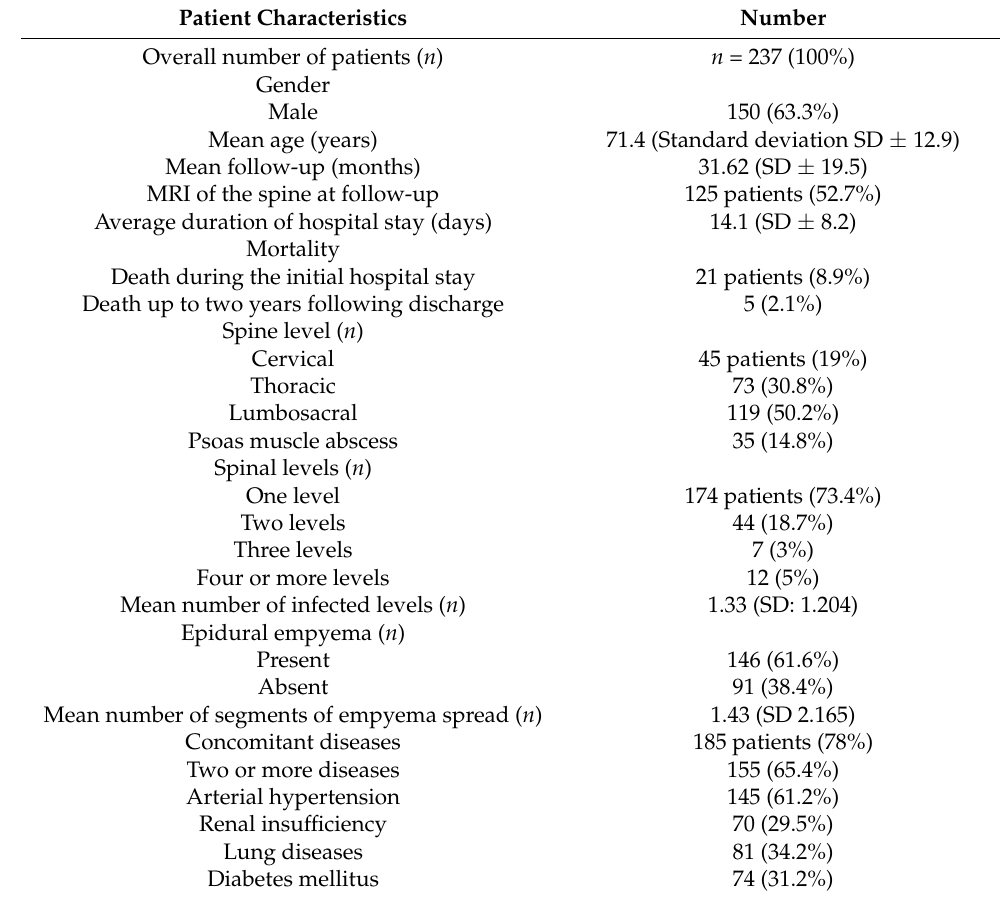
Table 1. General characteristics of the